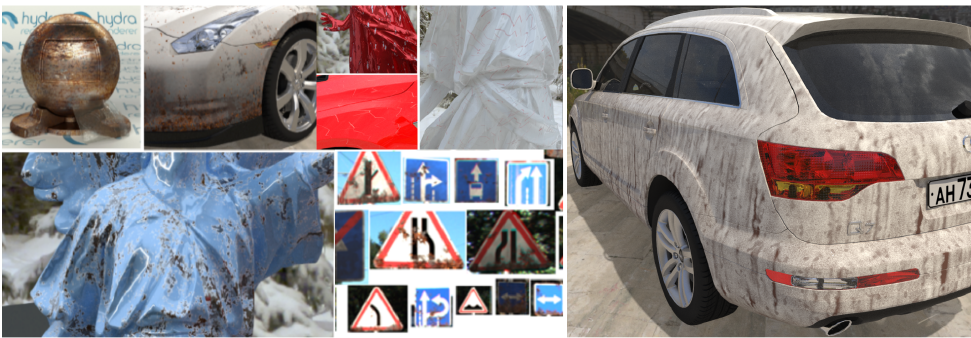
Figure 5. Examples of developed procedural